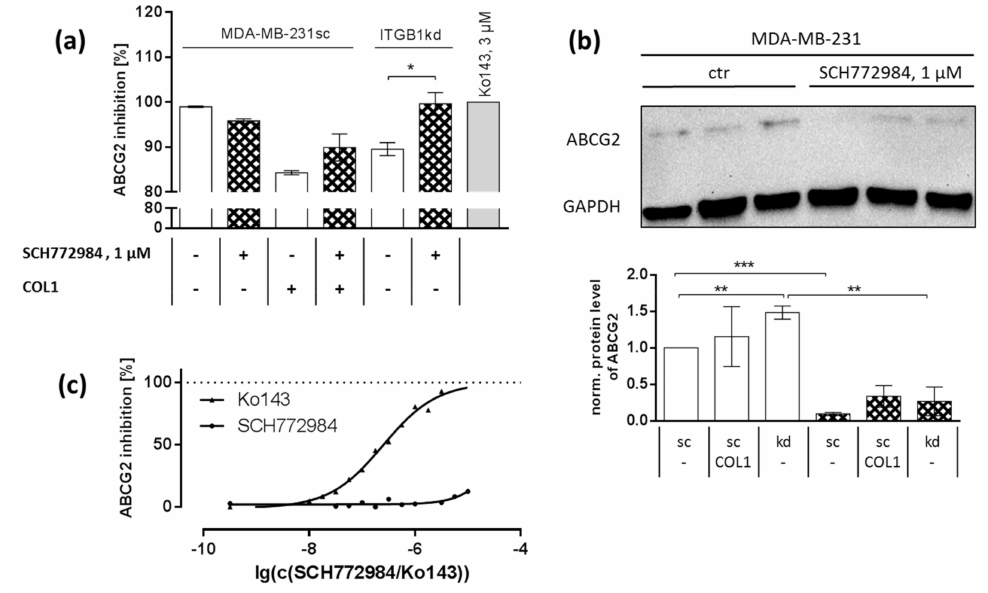
Figure 6. The ABC drug e ffl ux transporter ABCG2 is upregulated by collagen type 1 (COL1) via the MAPK pathway in MDA-MB-231 cells. ( a ) Functional ABCG2 activity assay using the ABCG2 substrate pheophorbide A and its inhibition by SCH772984 which is visible in scrambled (sc) cells in presence of COL1 and in integrin β 1 -knockdown (ITGB1-kd) cells The e ff ect of 24 h incubation of SCH772984 (1 µ M) was shown to reduce expression of ABCG2 in sc, COL1-treated and ITGB1-kd cells in Western blot experiments using GAPDH as loading control ( b ) (in both figures n = at least 3 biological samples). ( c ) Analysis of the inhibitory properties of SCH77284 itself in ABCG2 overexpressing MDCK II BCRP cells revealed no intrinsic inhibitory e ff ect in comparison to BCRP inhibitor Ko143 at all up to the concentration of 1 µ M used (n = at least 3 biological samples). Statistical analysis was performed via unpaired t -test (* p < 0.05; ** p < 0.01; *** p <